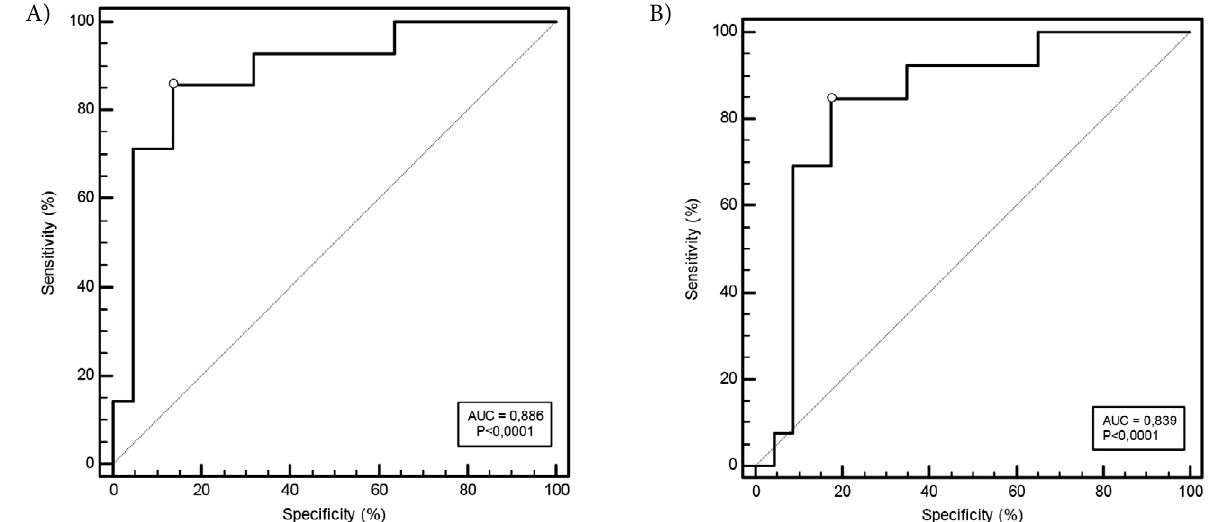
Figure 2: ROC curve for 8-OHdG in PCOS patient group classify on two different outcomes (A-mature oocytes; B-fertilized